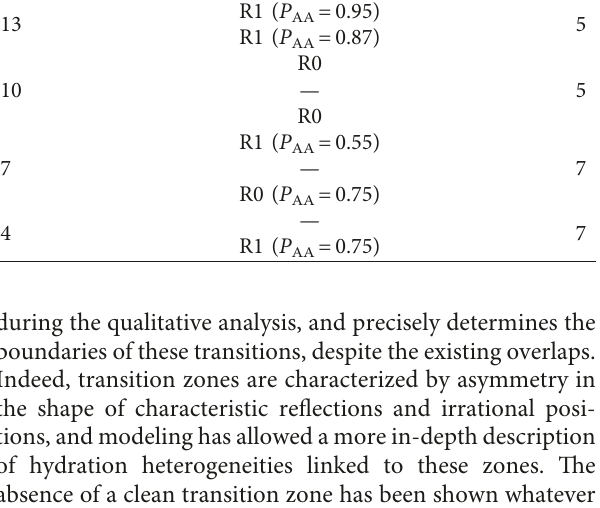
Table 4: Some structural parameters obtained from the quanti- tative XRD analysis in the case of the stressed sample along the desorption